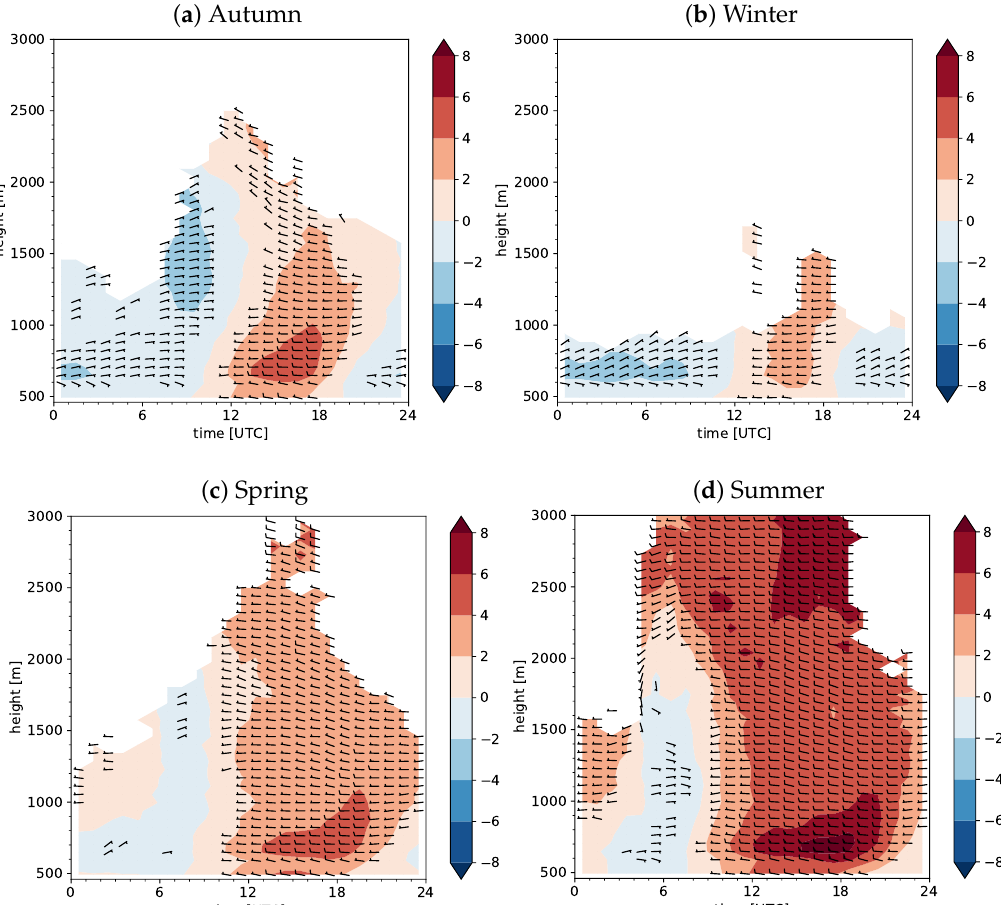
Figure 6. Mean diurnal cycle of the valley wind (vector-averaged) for the four seasons, based on the low-mode wind profiler and the weather station data. The filled contours indicate the along-valley wind speed (ms − 1 ) with positive values for up-valley wind, the barbs denote the wind direction with respect to the valley’s axis. The wind speed is masked if more than 50% of the values are missing and wind barbs are plotted if the wind speed is greater than 2.5